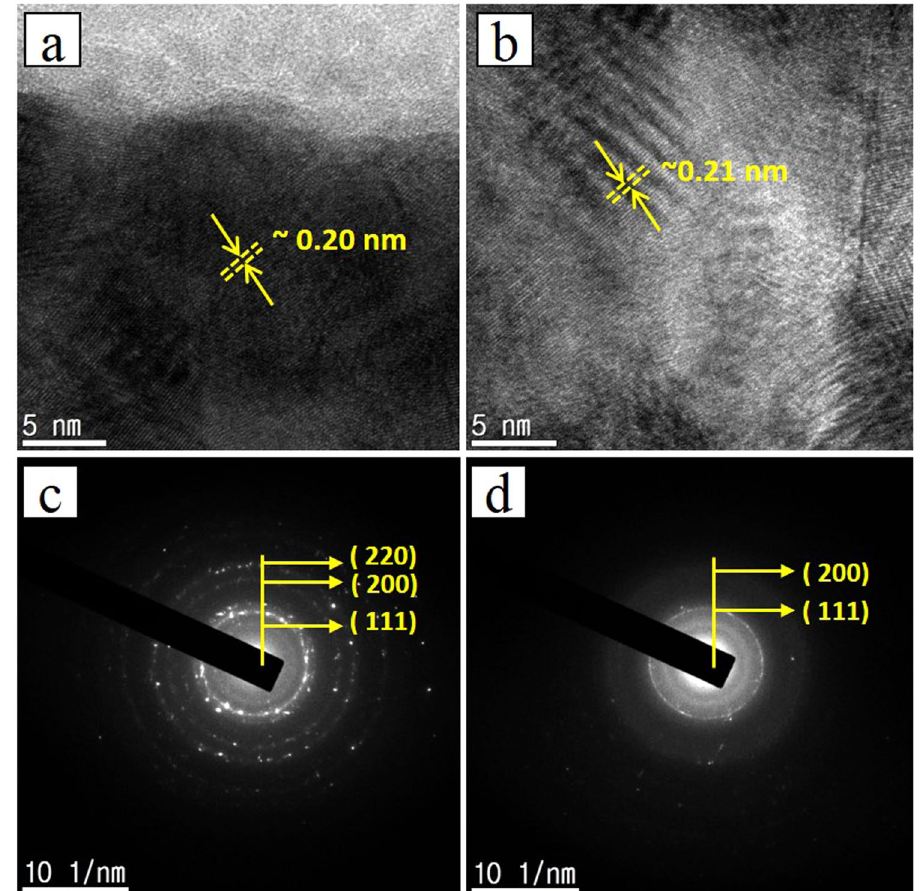
Figure 4. ( a ) HRTEM image of NiFe, ( b ) HRTEM image of Cu, ( c ) SAED pattern of NiFe, ( d ) SAED pattern of